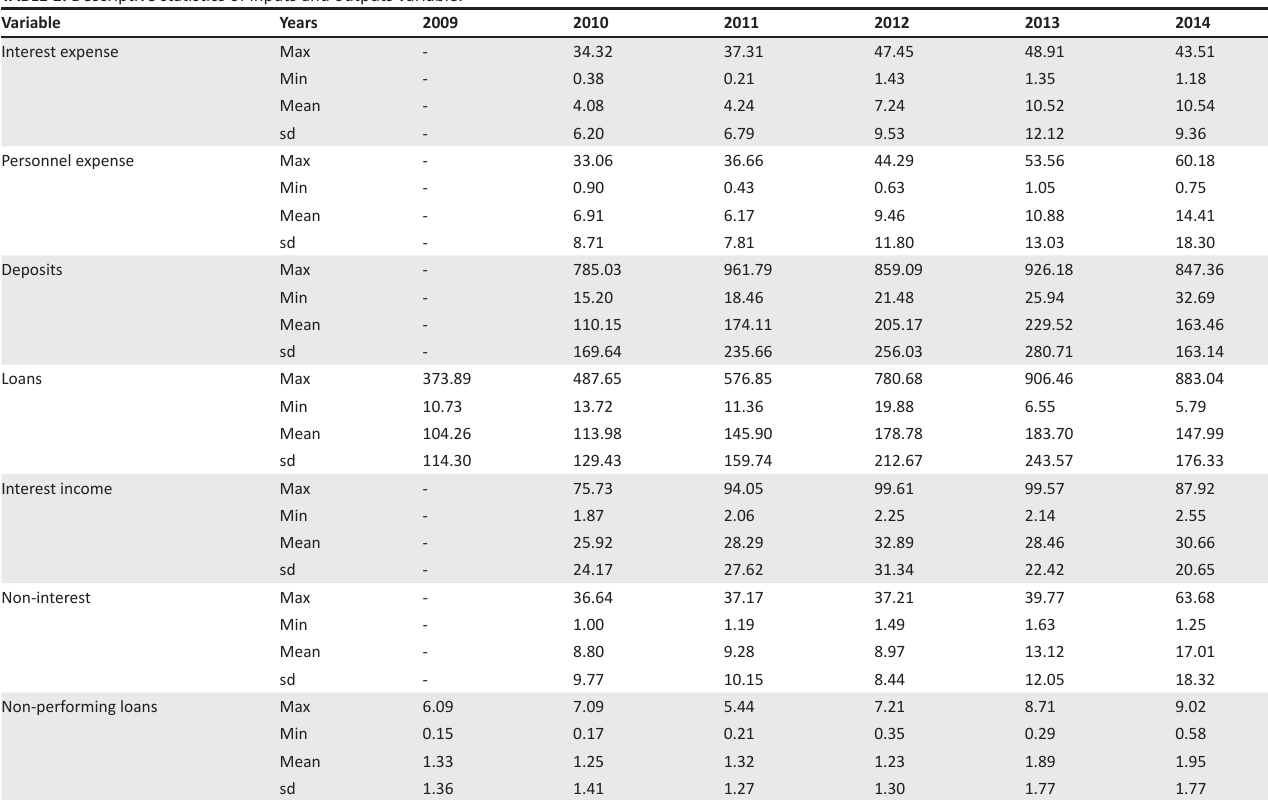
TABLE 1: Descriptive statistics of inputs and outputs variable.